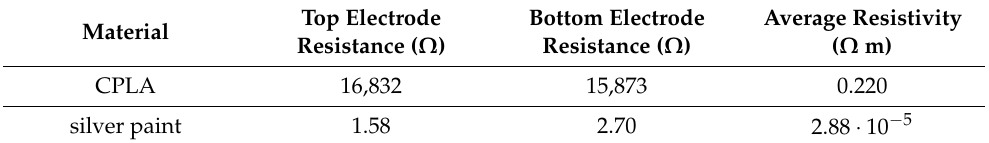
Table 1. Measured resistances of CPLA and silver paint electrodes and calculated average resistivi- ties ρ e